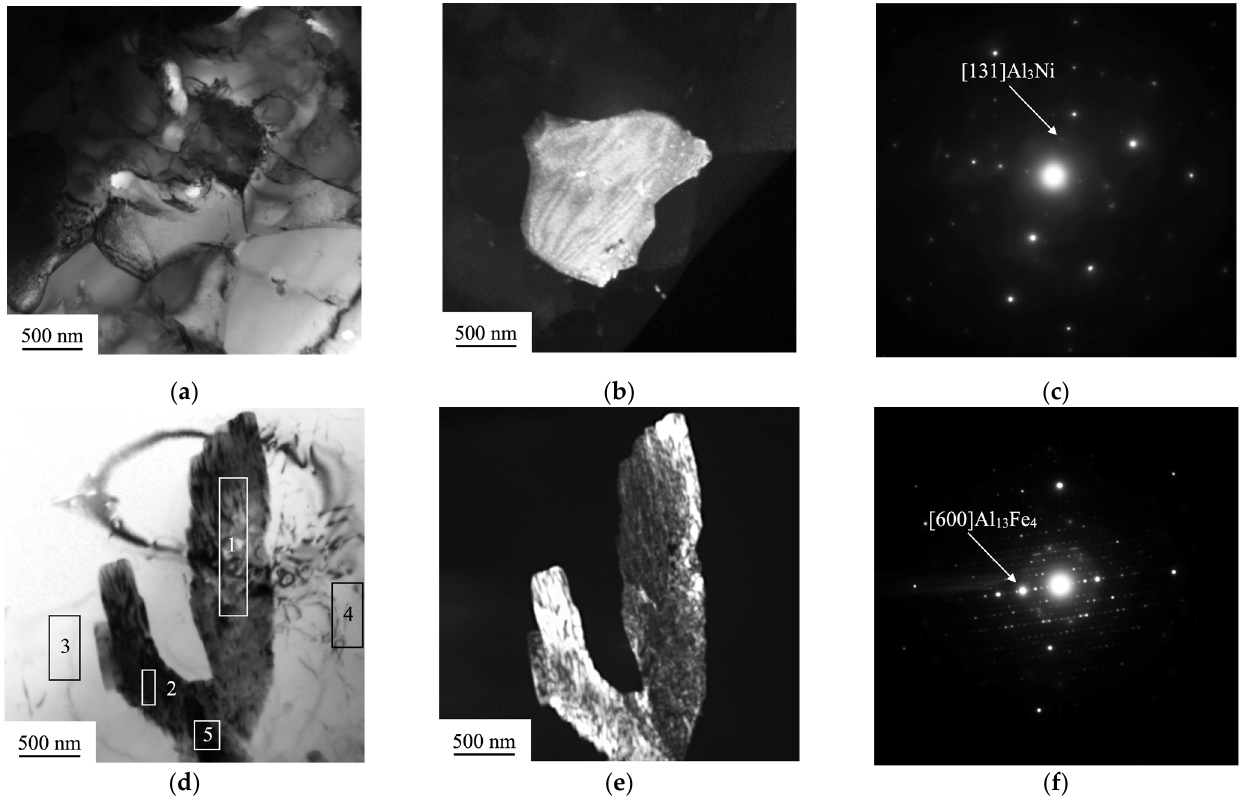
Figure 4. ( a ) TEM bright-field image of the light-gray area indicated in Figure 2; ( b ) TEM dark-field image of the second-phase particle Al 3 Ni; ( c ) Selected area diffraction pattern originating from the crystal oriented with [131]; ( d ) TEM bright-field image of a second-phase precipitation; the numbers indicate areas from which an elemental analysis was made; ( e ) TEM dark-field image of the second- phase precipitation Al 13 Fe 4 ; ( f ) selected area diffraction pattern originating from the crystal oriented with [600]. Table 1. Chemical composition of second-phase precipitations in the transition zone (at. %).